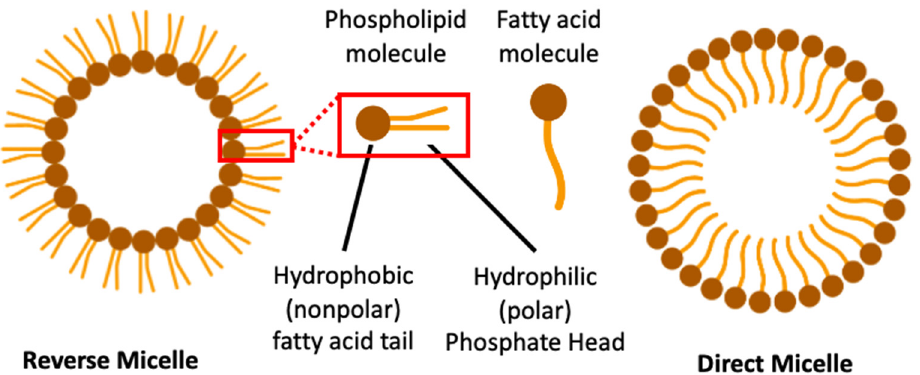
Figure 5. Showing the reverse and direct micellar structures. Micelle nanovectors consist of direct micelles with the anti-cancer agent positioned either on the surface for hydrophilic drugs (e.g., antisense oligonucleotide for example) or inside for hydrophobic drugs (e.g., chemotherapeutic agents). (Created with Biorender).